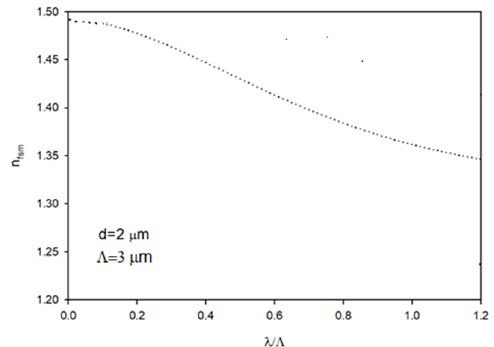
Figure 2. Effective RI of the cladding as a function of 𝜆/𝛬